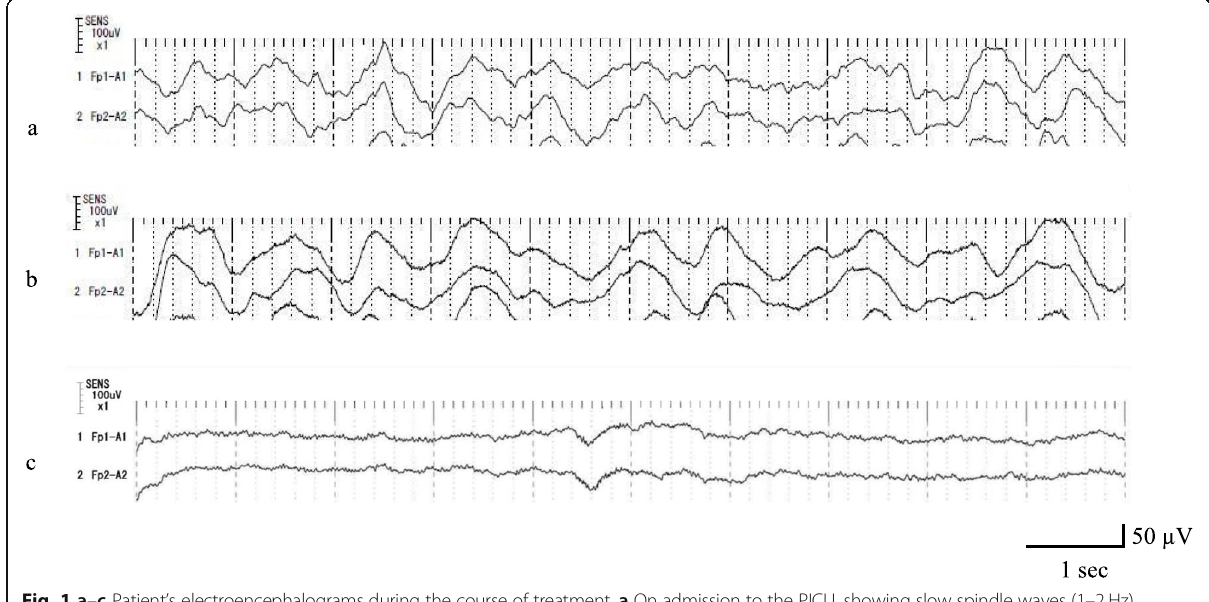
Fig. 1 a – c Patient ’ s electroencephalograms during the course of treatment. a On admission to the PICU, showing slow spindle waves (1 – 2Hz) without laterality and triphasic waves. b One day before surgery, showing high voltage continuous slow waves (0.5 – 1Hz) without laterality. c On postoperative day 5, at rest with the eyes closed, showing low amplitude and fast waves (9 – 10Hz) without laterality or paroxysmal waves. Fp1-A1 and Fp2-A2: left and right front polar-auricular. Only representative EEG waves are presented, because there were no remarkable changes in specific